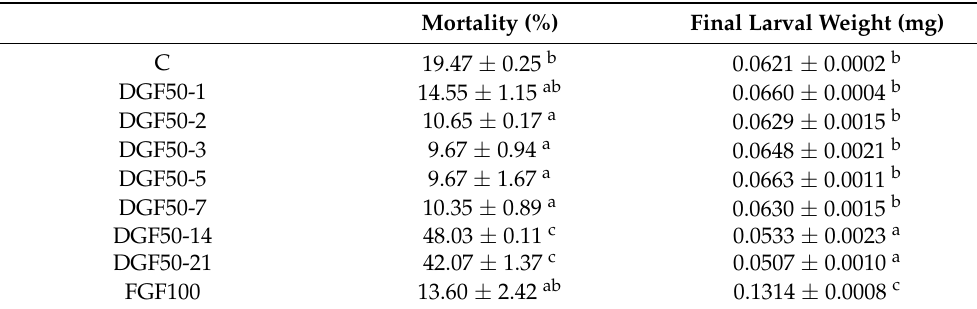
Table 2. Mortality and final larval weight (g) of individual larvae of Tenebrio molitor fed with control and fish-based